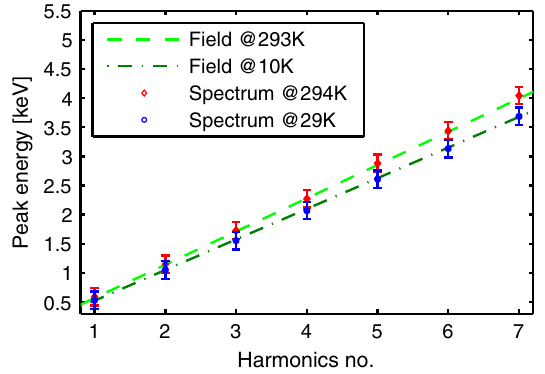
FIG. 4. The peak energies of the undulator spectrum measure- ment plotted against the corresponding harmonic number n . The data is detuning corrected, see Eq. (2), to compensate the redshift caused by the detector aperture. The dashed lines show the expected peak energies resulting from a magnetic field Hall- probe measurement done by the Helmholtz Zentrum Berlin. The error bars are given by the energy resolution of the Germanium detector of 150 eV